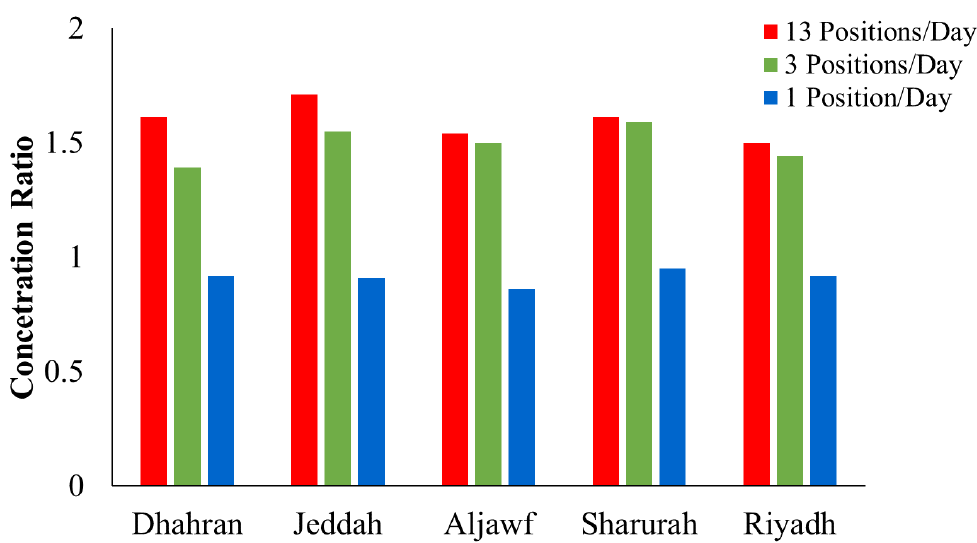
Figure 9. The CR of a V-trough system at five geographical locations for double